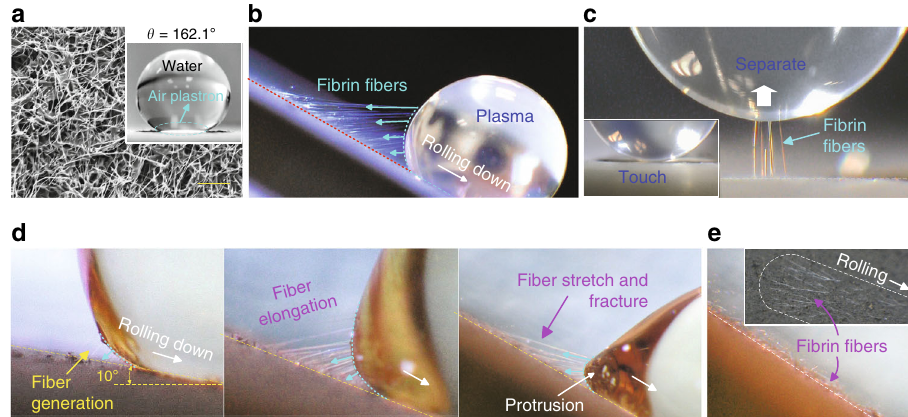
Fig. 1 Fibrin fi ber generation on the superhydrophobic CNF surface. a SEM image of the superhydrophobic CNF/PTFE Ti surface and a water droplet sitting on this surface demonstrates excellent superhydrophobicity. b Long fi brin fi bers generated at the receding side of a 10 μ l EDTA PPP droplet. c Touch-lift test of a PPP droplet on the CNF surface, showing fi ber generation upon EDTA PPP-substrate separation. d Zoomed-in sequential frames of the fi ber generation and fracture during the EDTA PPP droplet (20 μ l) rolling down motion (Supplementary Movie 1). e Visible fi brin fi ber footprints left on the CNF surface after the PPP sliding test (inset is a top view). Scale bar is 10 μ m in a .